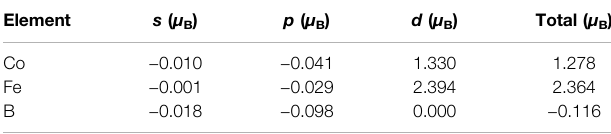
TABLE2| Magneticmomentsof s , p , d ,andTotalorbitalsfortheatomsintheCo- Fe-B system.